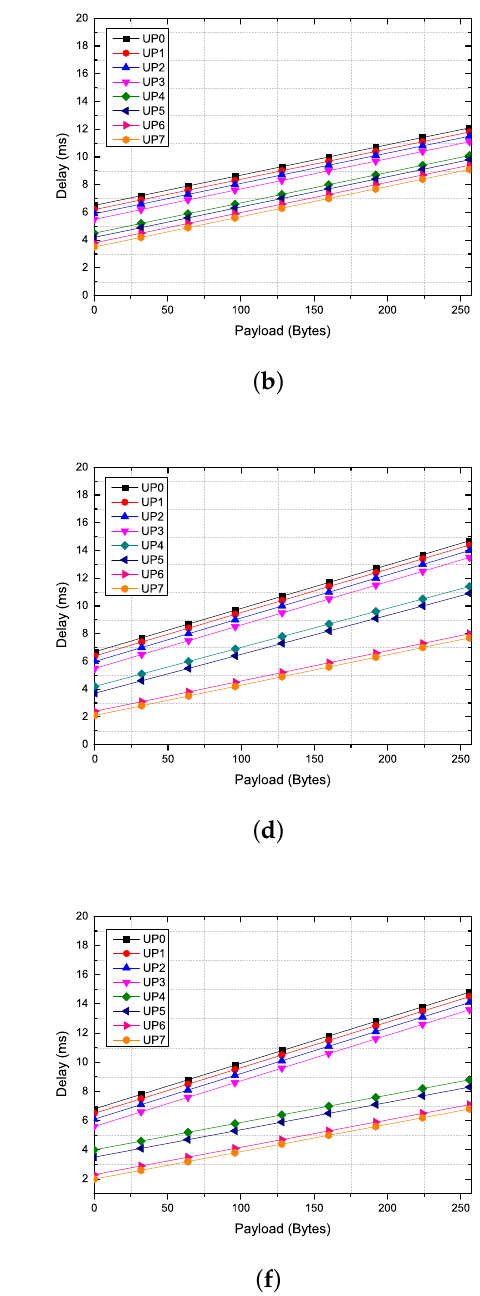
Figure 13. Performance comparison for different payloads under scenario 1: impact of varying payload on ( a ) throughput (Case 1), ( b ) average delay (Case 1), ( c ) throughput (Case 2), ( d ) average delay (Case 2), ( e ) throughput (Case 3), and ( f ) average delay (Case 3). For case 3, MAP 1 and 2, including a scheduled uplink, downlink, bi-link allocation interval, unscheduled bi-link interval, and improvised polling interval, are added to the superframe. By adding the type-I (immediate) polled allocation intervals to the MAP, unscheduled allocation intervals can be provided to critical nodes and wasted time slots can be reduced by adjusting the length of the scheduled uplink allocation interval. For example, owing to the UP-based scheduling policy, in case 2, the waste of uplink allocated slots may increase according to the data rates of the critical nodes (i.e., UP 6 and UP 7 ). However, in case 3, nodes with higher UPs can be assigned additional